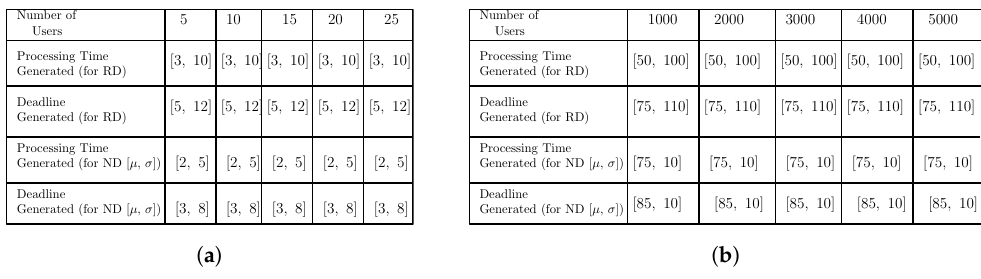
Figure 7. Data set (DS) used for comparing TM-FSA and RM-FSA.